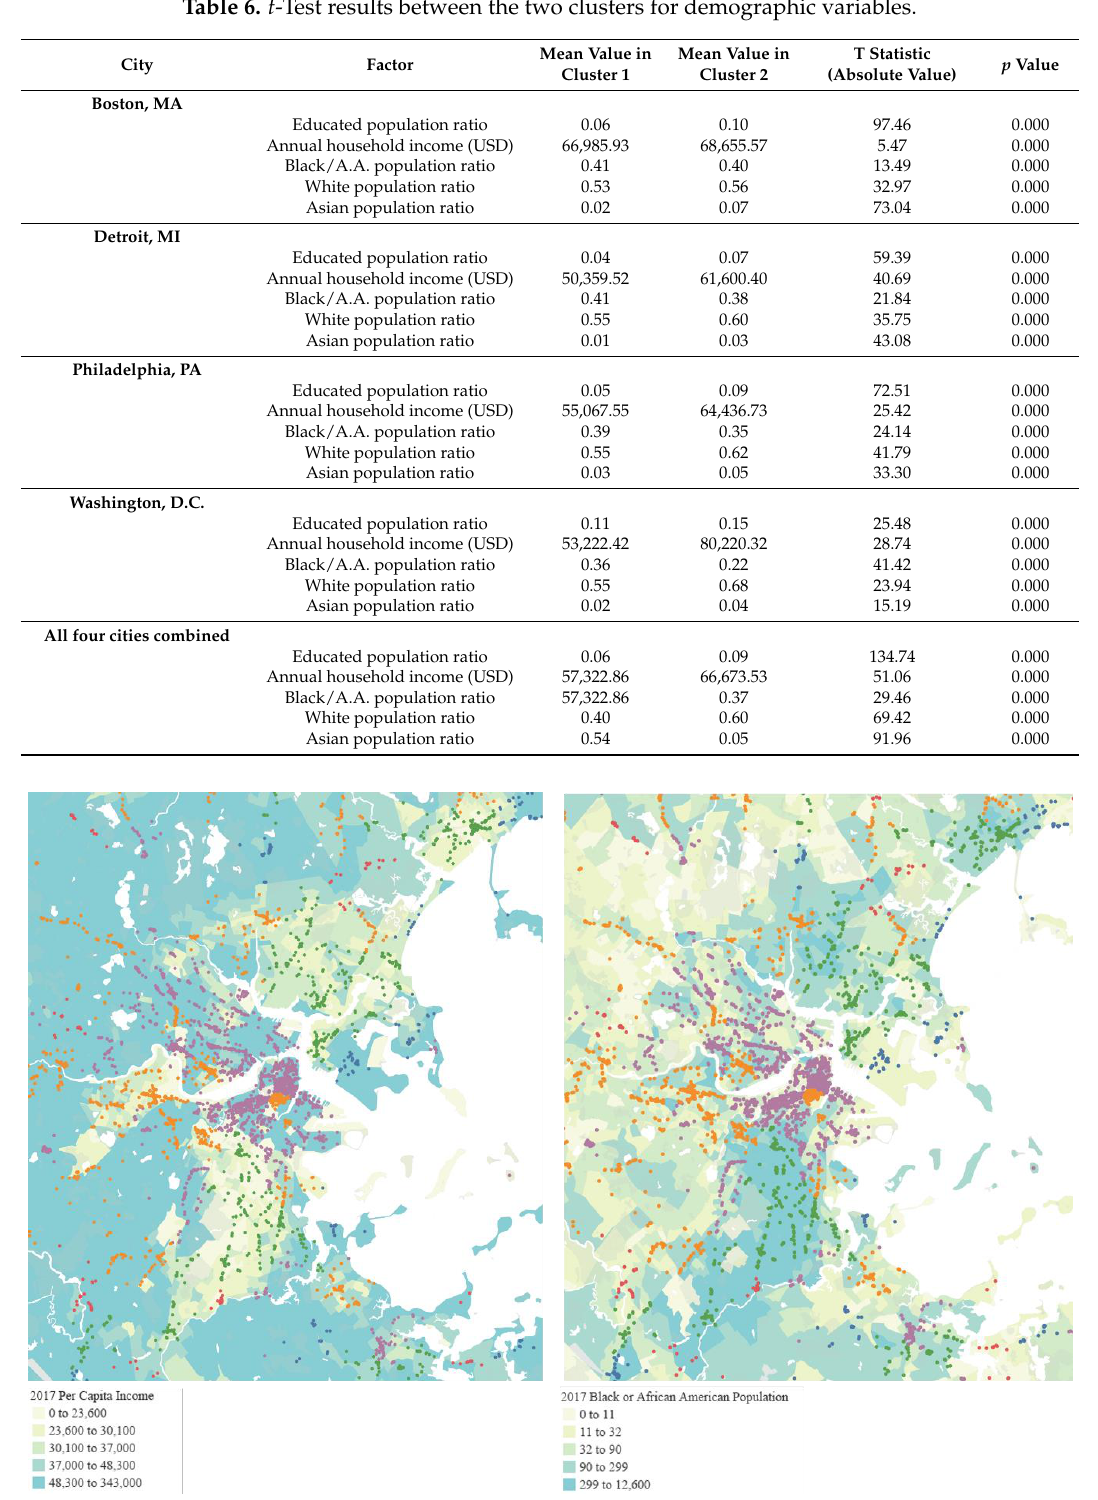
Figure 10. Clustering results with 5 clusters for Boston.